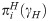
HVG and LVG detection.(a) and (b): for each of the 7,895 biological genes, gene-specific expression rate μ
i (log scale) against the probability of being HVG (πiH(γH)) and the probability of being LVG (πiL(γL)), respectively. Setting the EFDR and the EFNR equal to 10%, the corresponding variance contribution thresholds are γ
H = 79% and γ
L = 41%. Black dashed lines located at optimal (i.e. when EFDR and EFNR coincide) evidence thresholds α
H = 0.7925 and α
L = 0.7650, respectively. The 133 and 589 genes classified as HVG and LVG are highlighted in red and blue, respectively.